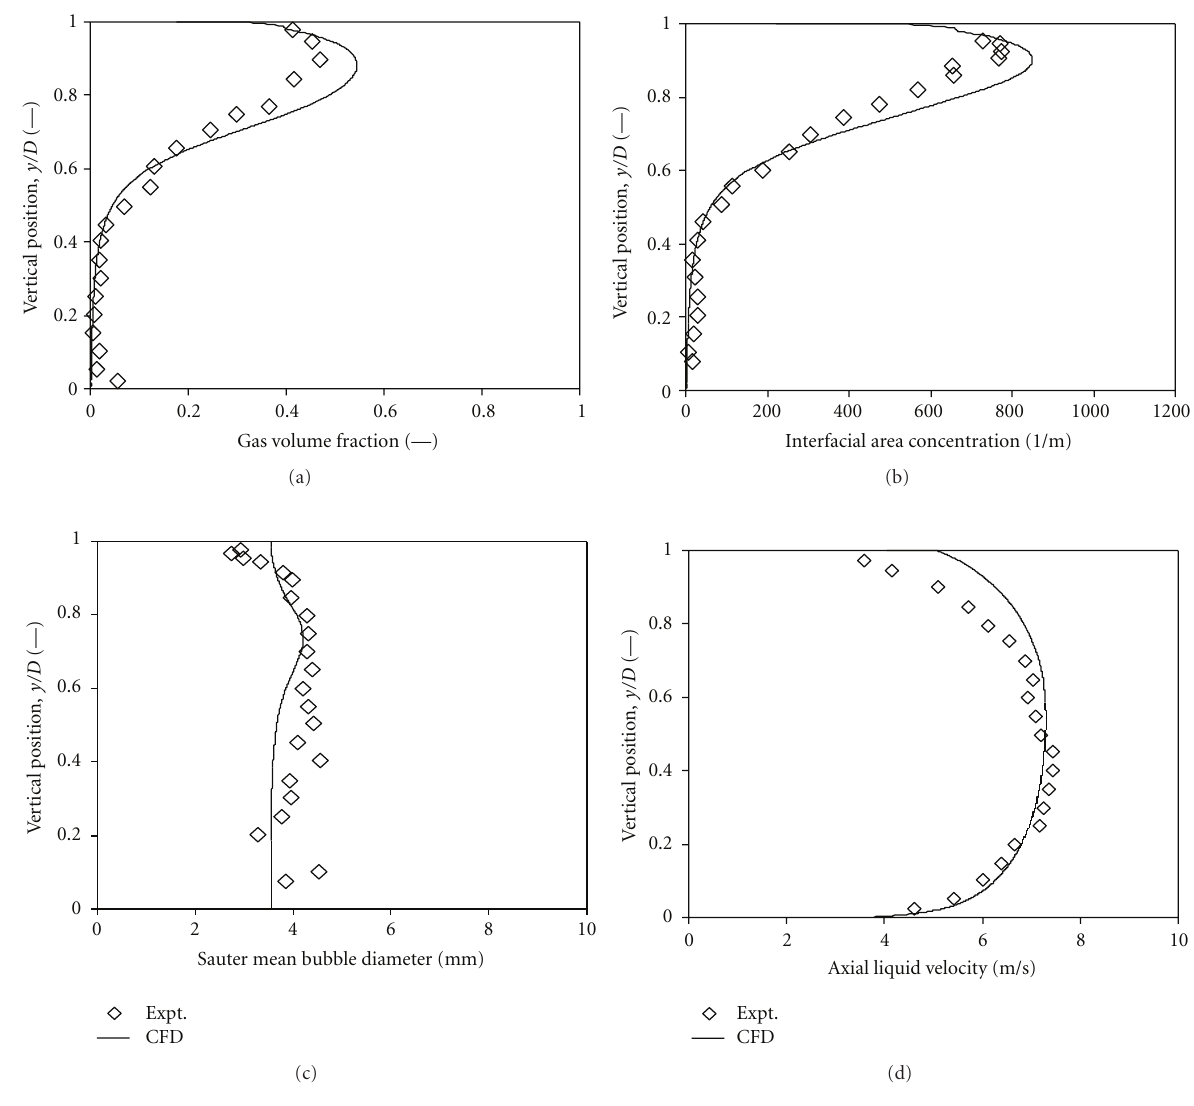
Figure 5: Comparison of predicted and experimental data of Kocamustafaogullari and Wang [17] for superficial gas velocity of 0.80 m/s, superficial liquid velocity of 5.1m/s, and volume fraction of 0.139; (a) gas volume fraction, (b) interfacial area concentration, (c) Sauter mean bubble diameter, and (d) axial liquid